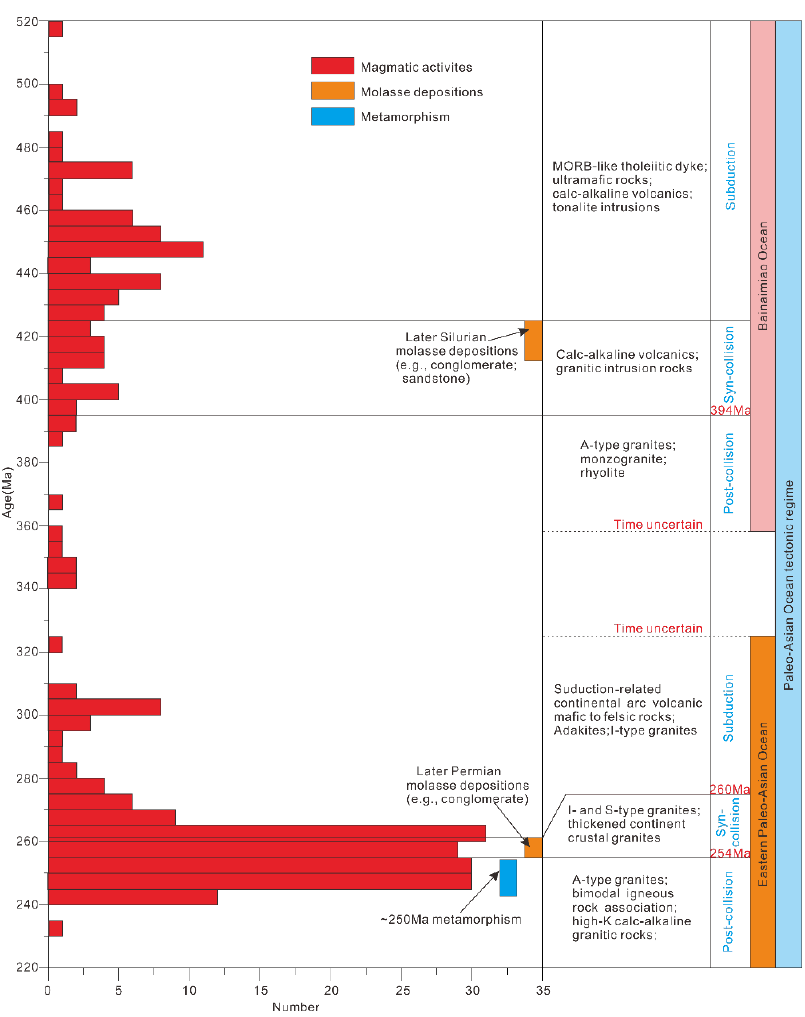
Figure 13. Histogram of zircon U–Pb ages from Paleozoic to Triassic magmatism in the southeastern CAOB. Ages (in Ma); references are listed in Supplementary Table S1.